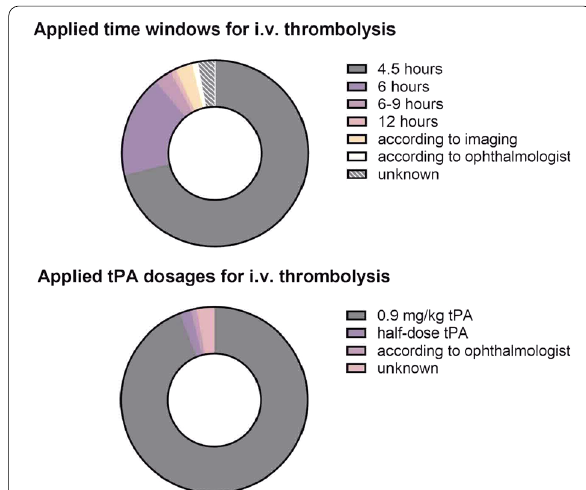
Fig. 1 Differences in time-window for treatment and tPA dosage for intravenous thrombolysis in in patients with central retinal arterial occlusion as applied by the responders. tPA: tissue plasminogen activator